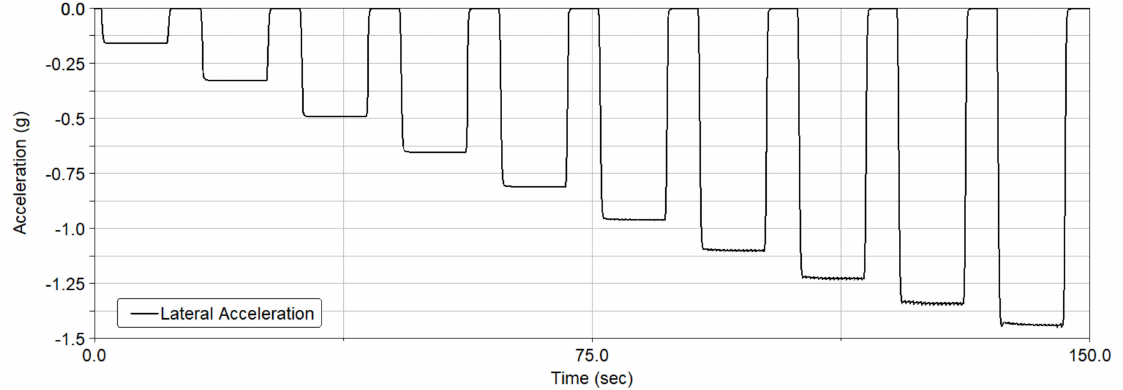
Figure 4. Skid-pad virtual test via successive step-steer maneuvers, vehicle output-lateral acceleration.